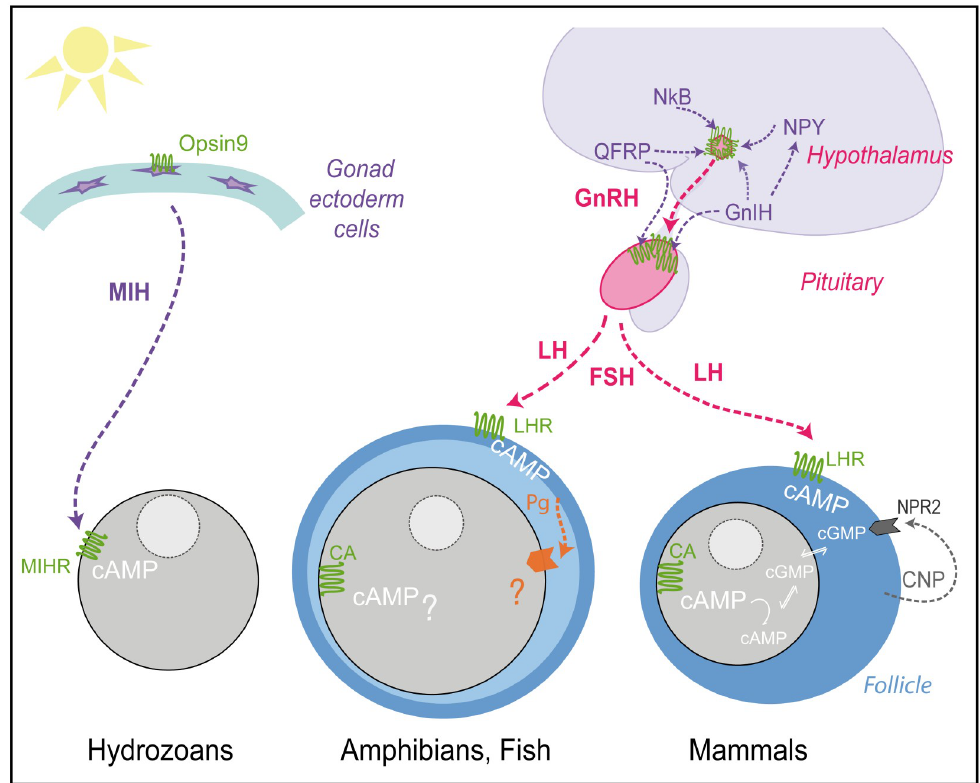
Fig 7. Schematic comparison of GPCR regulation of Clytia and vertebrate oocyte maturation. Simplified view of the tissues, hormones, and receptors involved in regulating oocyte maturation in Clytia and in fish/amphibians and mammals. For simplicity, we have not included protostome or echinoderm models. The principle peptide hormones of the reproductive hypothalamus-pituitary-gonadal axis (GnRH and LH/FSH) are in pink, and those for which the receptors group phylogenetically with Clytia MIHR in “Group A” (Fig 6) are in purple. Peptide hormones: Clytia MIH, Neuropeptide Y (NPY), GnIH, GnRH, LH, QRFP, NkB, and C-type natriuretic peptide (CNP). All their receptors, except the guanylyl cyclase natriuretic peptide receptor 2 (NPR2) activated by CNP, are GPCRs (green). Constitutively active (CA) GPCRs in vertebrate oocytes maintain cytoplasmic cAMP levels high prior to maturation. In mouse oocytes, a cAMP decrease upon hormone stimulation triggers maturation; however, in fish and frog oocytes the degree and role of this decrease is debated. Several types of oocytes receptor (orange) may respond to steroid hormones (Pg) in different species of amphibians and fish, but the relative importance of multiple downstream signalling pathways remains to be clarified [1,43,44,45,46]. See text for discussion. CNP, C-type natriuretic peptide; FSH, follicle-stimulating hormone; GnIH, gonadotropin inhibitory hormone; GnRH, gonadotropin-releasing hormone; GPCR, G protein–coupled receptor; LH, luteinizing hormone; LHR, lutenizing hormone receptor; MIH, maturation-inducing hormone; MIHR, MIH